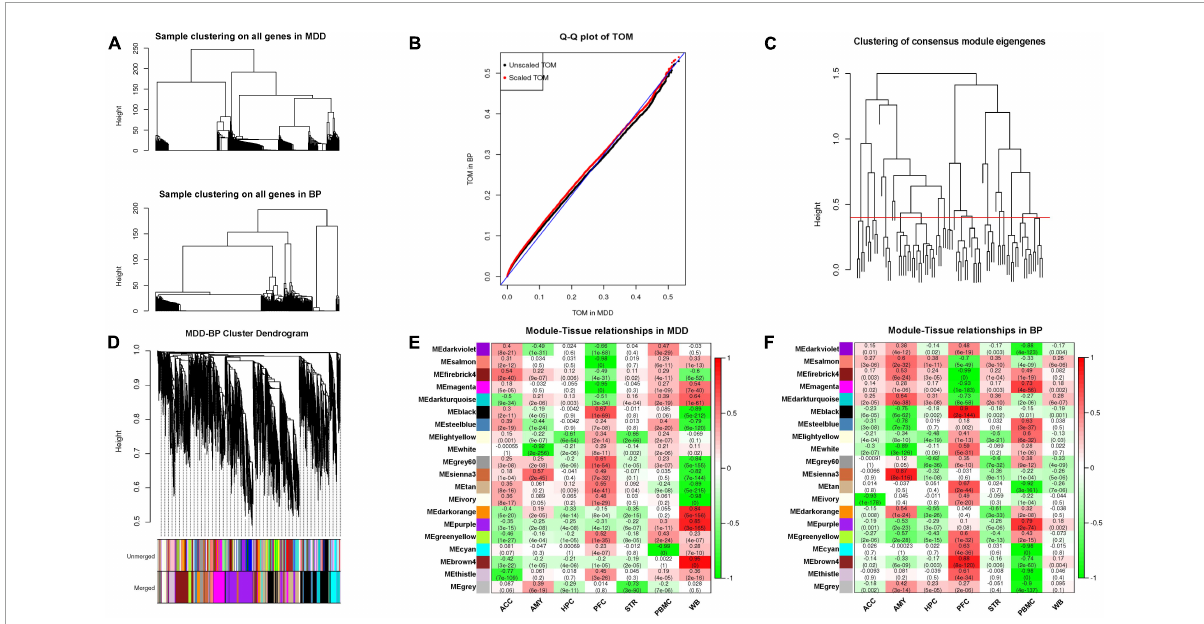
FIGURE3 (A) Hierarchical clustering using shared genes is similar to the clustering used for single disease. (B) Quantile-quantile plot of TOMs in MDD and BP. The black points are TOMs before scaling, and the red points are TOMs after scaling. The closer the points lie to the reference line shown in blue, the closer the distribution of TOM values in the two datasets. The closer the points in the graph are to the reference line marked in blue, the more similar the TOM distributions of the two datasets are. (C) The hierarchical clustering graph between co-expression network modules. Groups of eigengenes below the threshold represent modules whose expression profiles are too similar and should be merged. (D) Gene dendrogram obtained by clustering the dissimilarity based on consensus topological overlap. The two-color rows show the preliminary (unmerged) and final (merged) module assignments; in this study, 20 modules were obtained. (E,F) MDD and BP mainly contain modules with consistent expression and inconsistent expression.